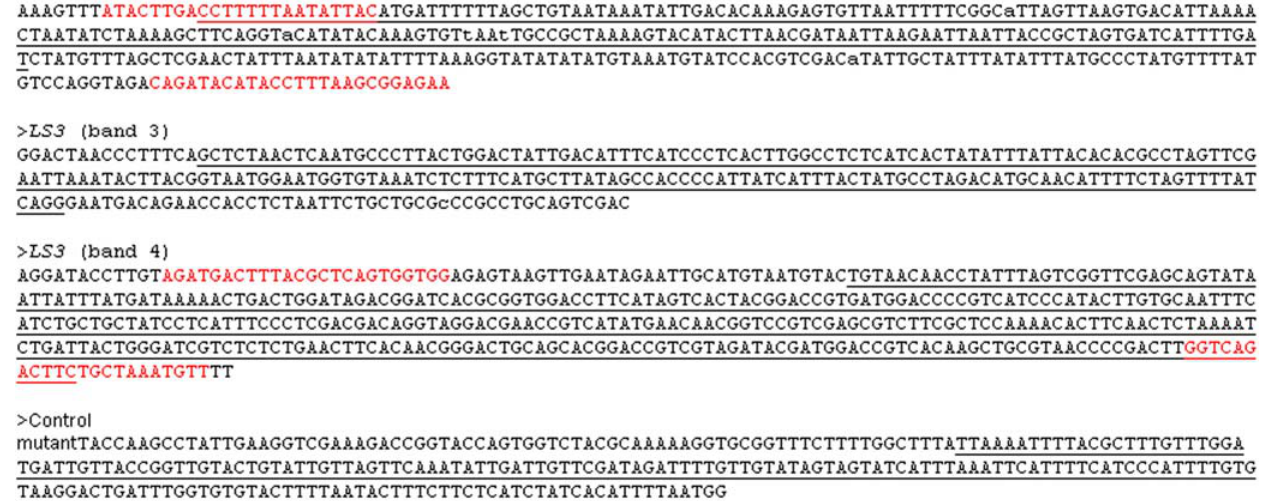
Figure 3. Insertion sequence from LS1 , LS2 and a control plant. Sequences in red for LS1 and LS3 (band 4) are PCR primers designed to detect the insertion sequence in wild type tomato genome. Underlined sequences are those that match tomato genomic DNA in GenBank and are used to generate data for Table 1. doi:10.1371/journal.pone.0002974.g003 Table 1. Number of insertion sequence matchs in the 12 tomato chromosomes.